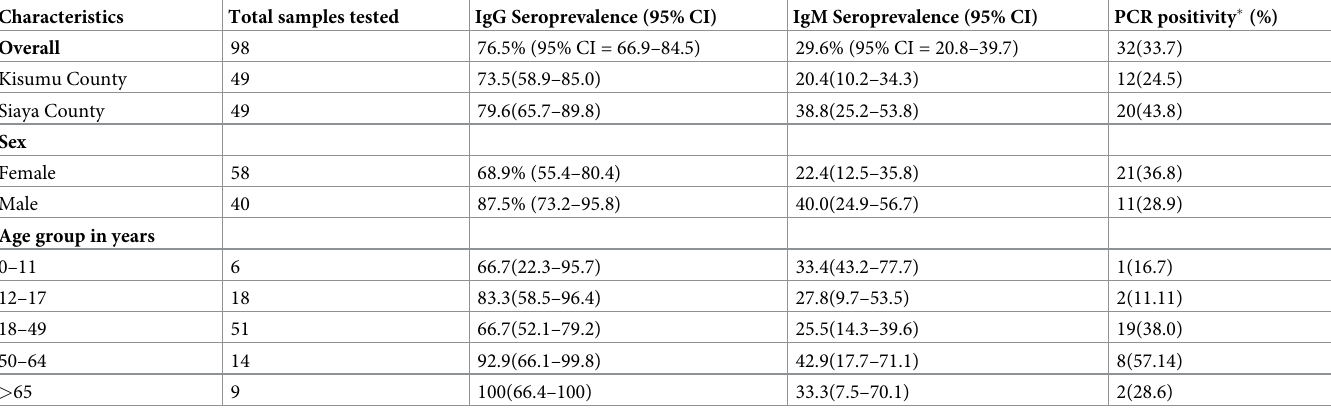
Table 1. Demographic characteristics, antibody responses and SARS-CoV-2 PCR results among study participants.